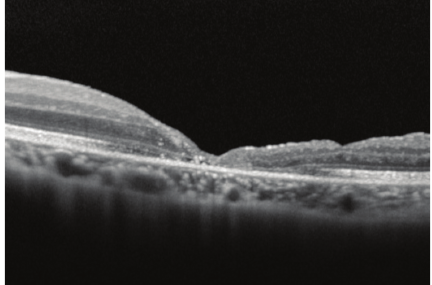
Figure 2: OCT after vitrectomy reveals a closed macular hole with a BCVA of